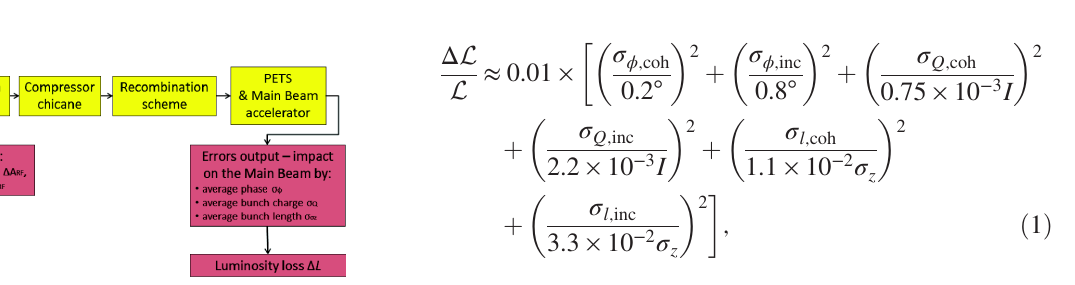
FIG. 2. Simplified process diagram of operation of drive beam error tracking simulation